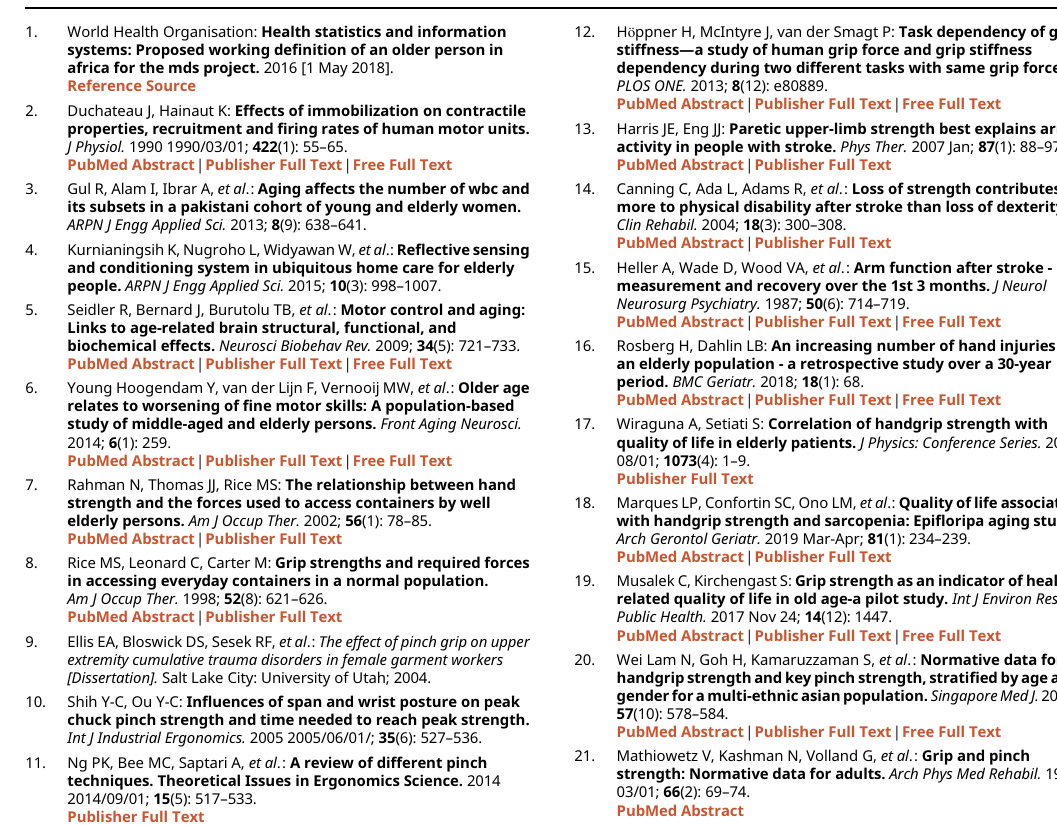
Figshare: A TRIZ-driven conceptualisation of finger grip enhancer designs for the elderly. http://doi.org/10.6084/m9. figshare.14498649.